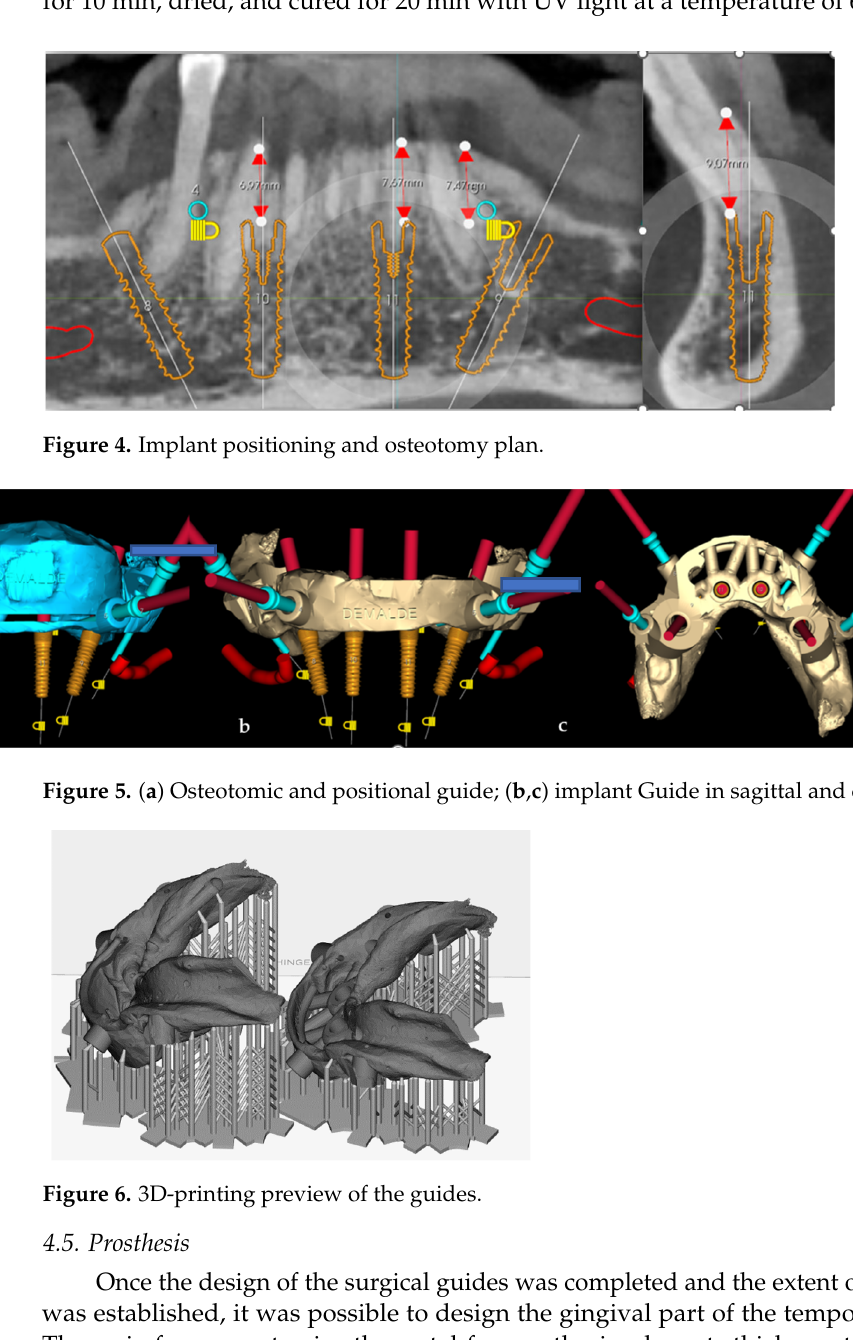
. Figure 7. 3D-printing preview of the provisional prosthesis. 4.6. Surgical Procedure The patient was prescribed Amoxicillin + Clavulanic Acid (875 mg + 125 mg) according to the following dosage regime: 2 g 1 h before surgery and then 1 g every 12 h for 6 days [56]. Before starting the surgical procedure (Figure 8), the patient’s oral cavity was rinsed with 0.30% chlorhexidine for one minute. The perioral surfaces were disinfected with gauze soaked in 0.30% chlorhexidine. After checking the fit of the positioning template and performing plexus anesthesia with mepivacaine and adrenaline (1:100,000), the anchor pins were inserted (Figure 9). Figure 8. Patient’s occlusion at T0.